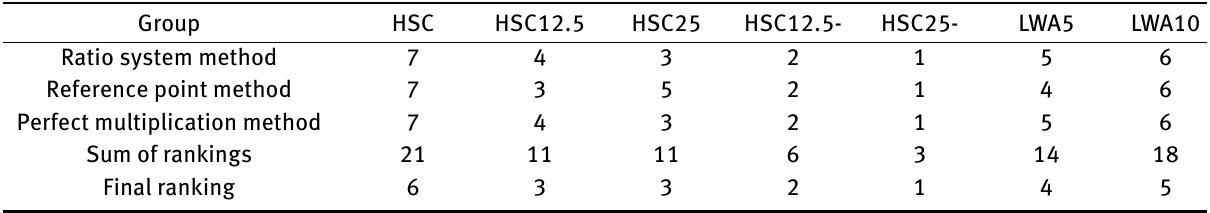
Perfect multiplication method Sum of